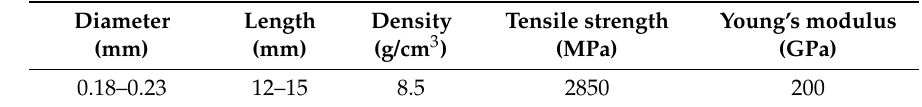
Table 3. Properties of steel fibres.